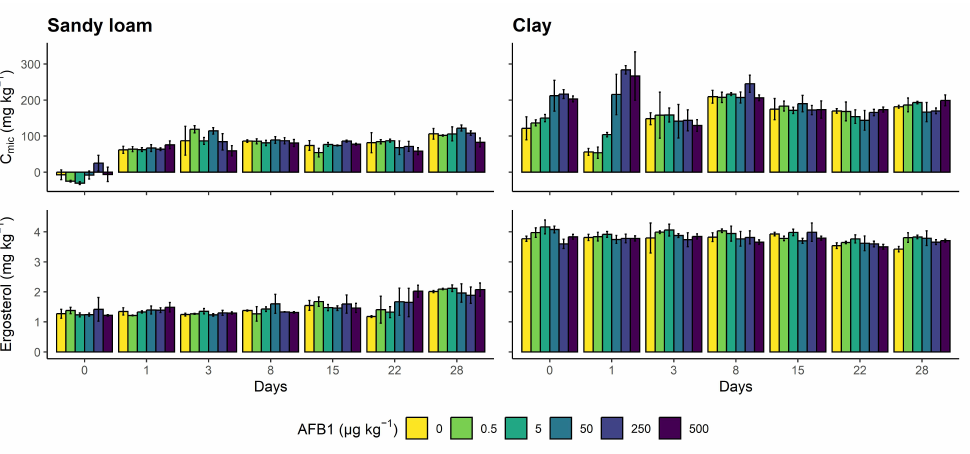
Figure A3. Microbial and fungal biomass: Barplots showing the average values for microbial biomass carbon (C mic ) and ergosterol as bioindicators for fungal biomass (ERG). The error bars represent the standard